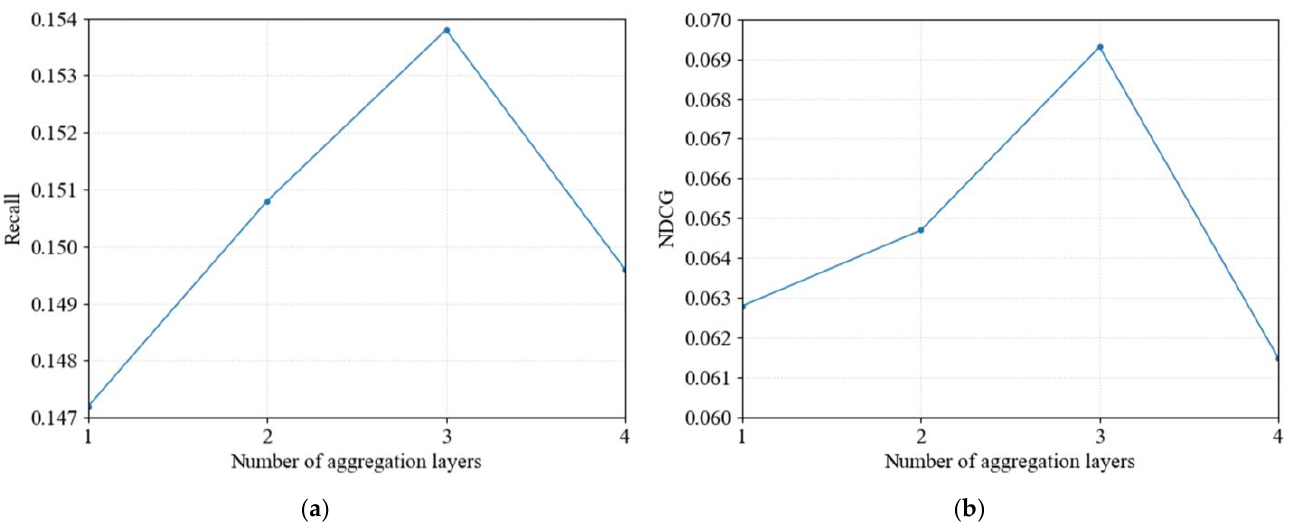
Figure 6. Effects of different aggregation layers 𝑙 on the algorithm. ( a ) Effect of 𝑙 on Recall; ( b ) Effect of 𝑙 on NDCG. Table 2. Experimental parameter settings.